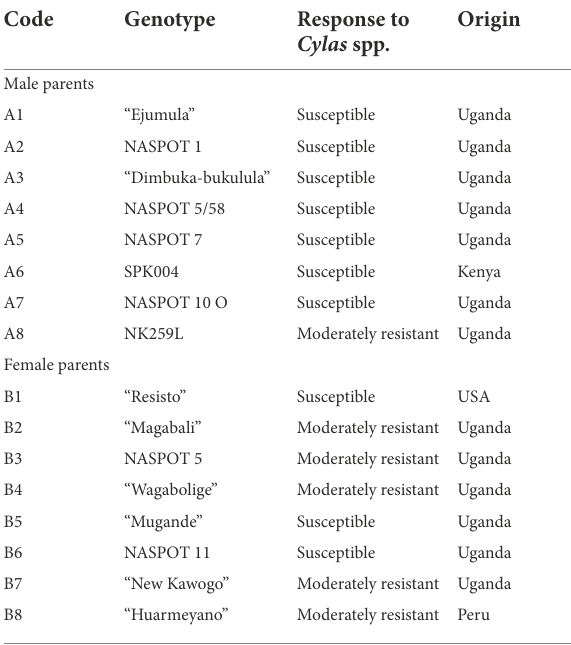
TABLE 1 Description of parental material utilized in the 8 × 8 paired cross. Code